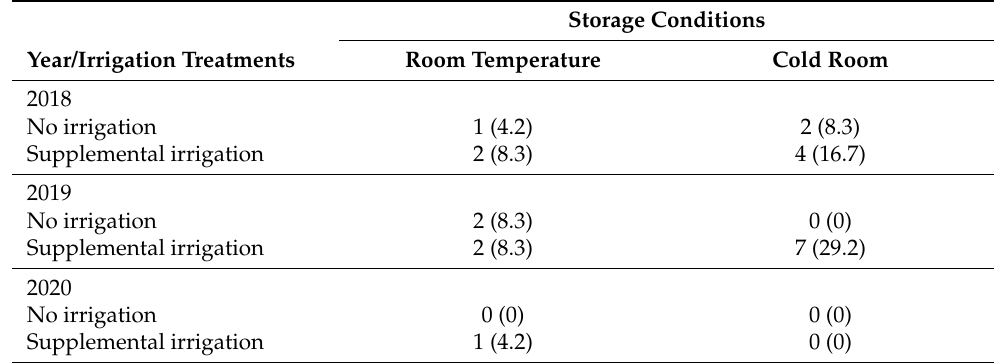
Table 6. Number and percentage (in brackets) of fruit with decay from ‘Roja Lisa’ cactus pear plants under different irrigation treatments and storage conditions in three consecutive growing